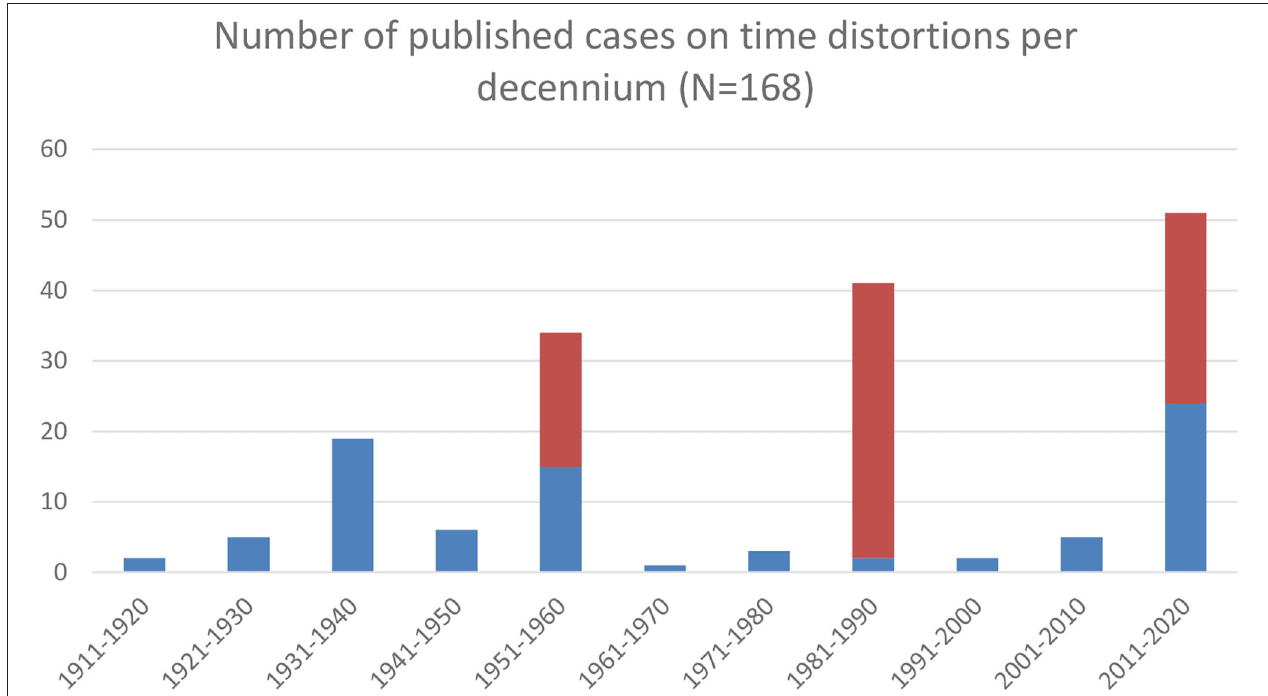
FIGURE 5 | Number of published cases on time distortions per decennium. Blue = individual case descriptions; red = cases from population studies.